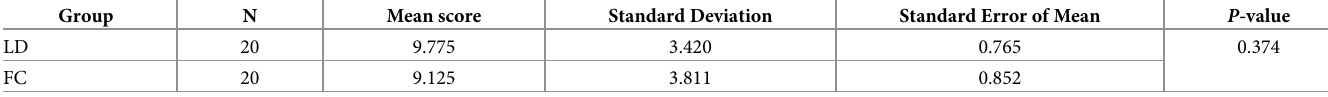
Table 3. Mean score obtained by students of both groups in the blind assessment of the Adams clasp wire-bending exercise.